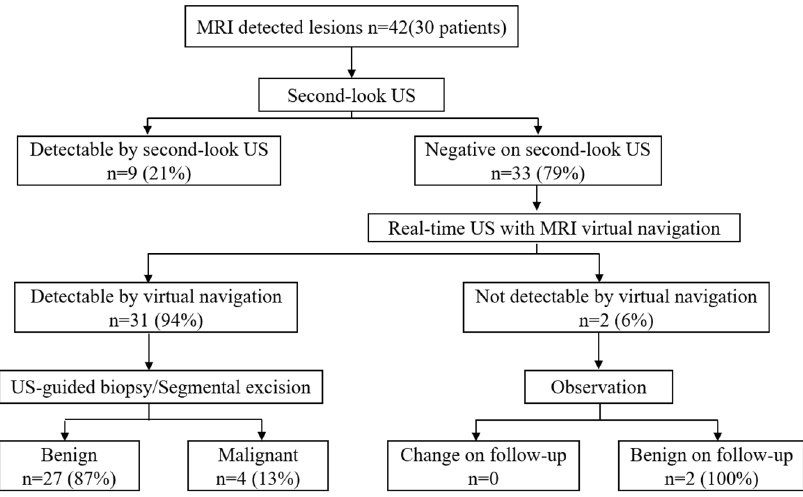
Figure 1. Flowchart of this study.